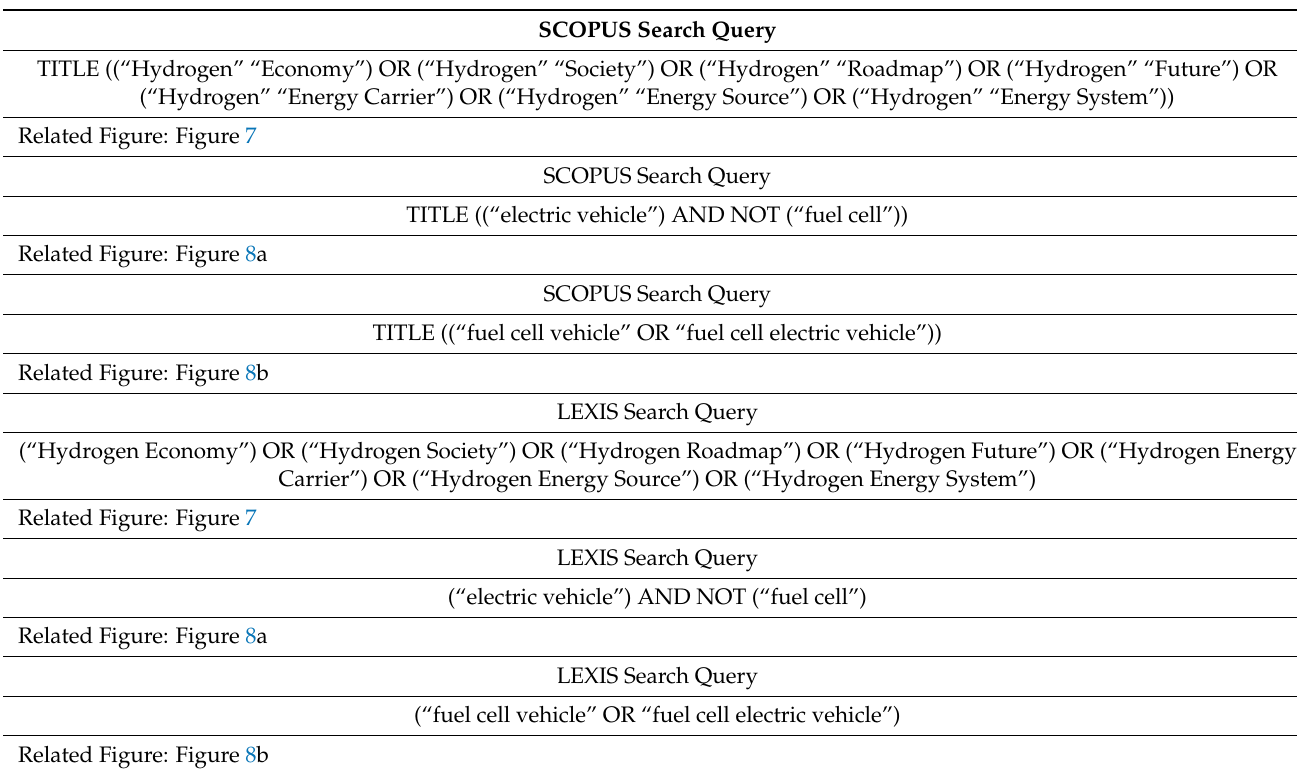
Table A1. Search query for SCOPUS and LEXIS database. SCOPUS Search Query